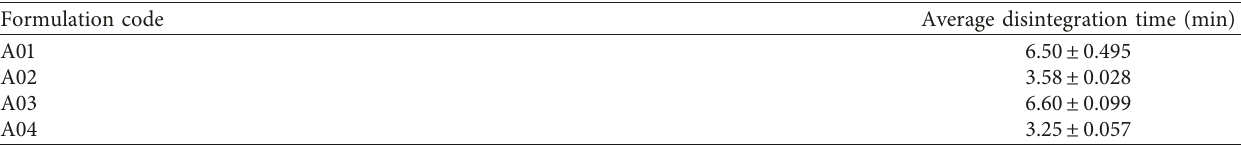
Table 4: Disintegration time of Antiaris africana capsules ( n � 6).